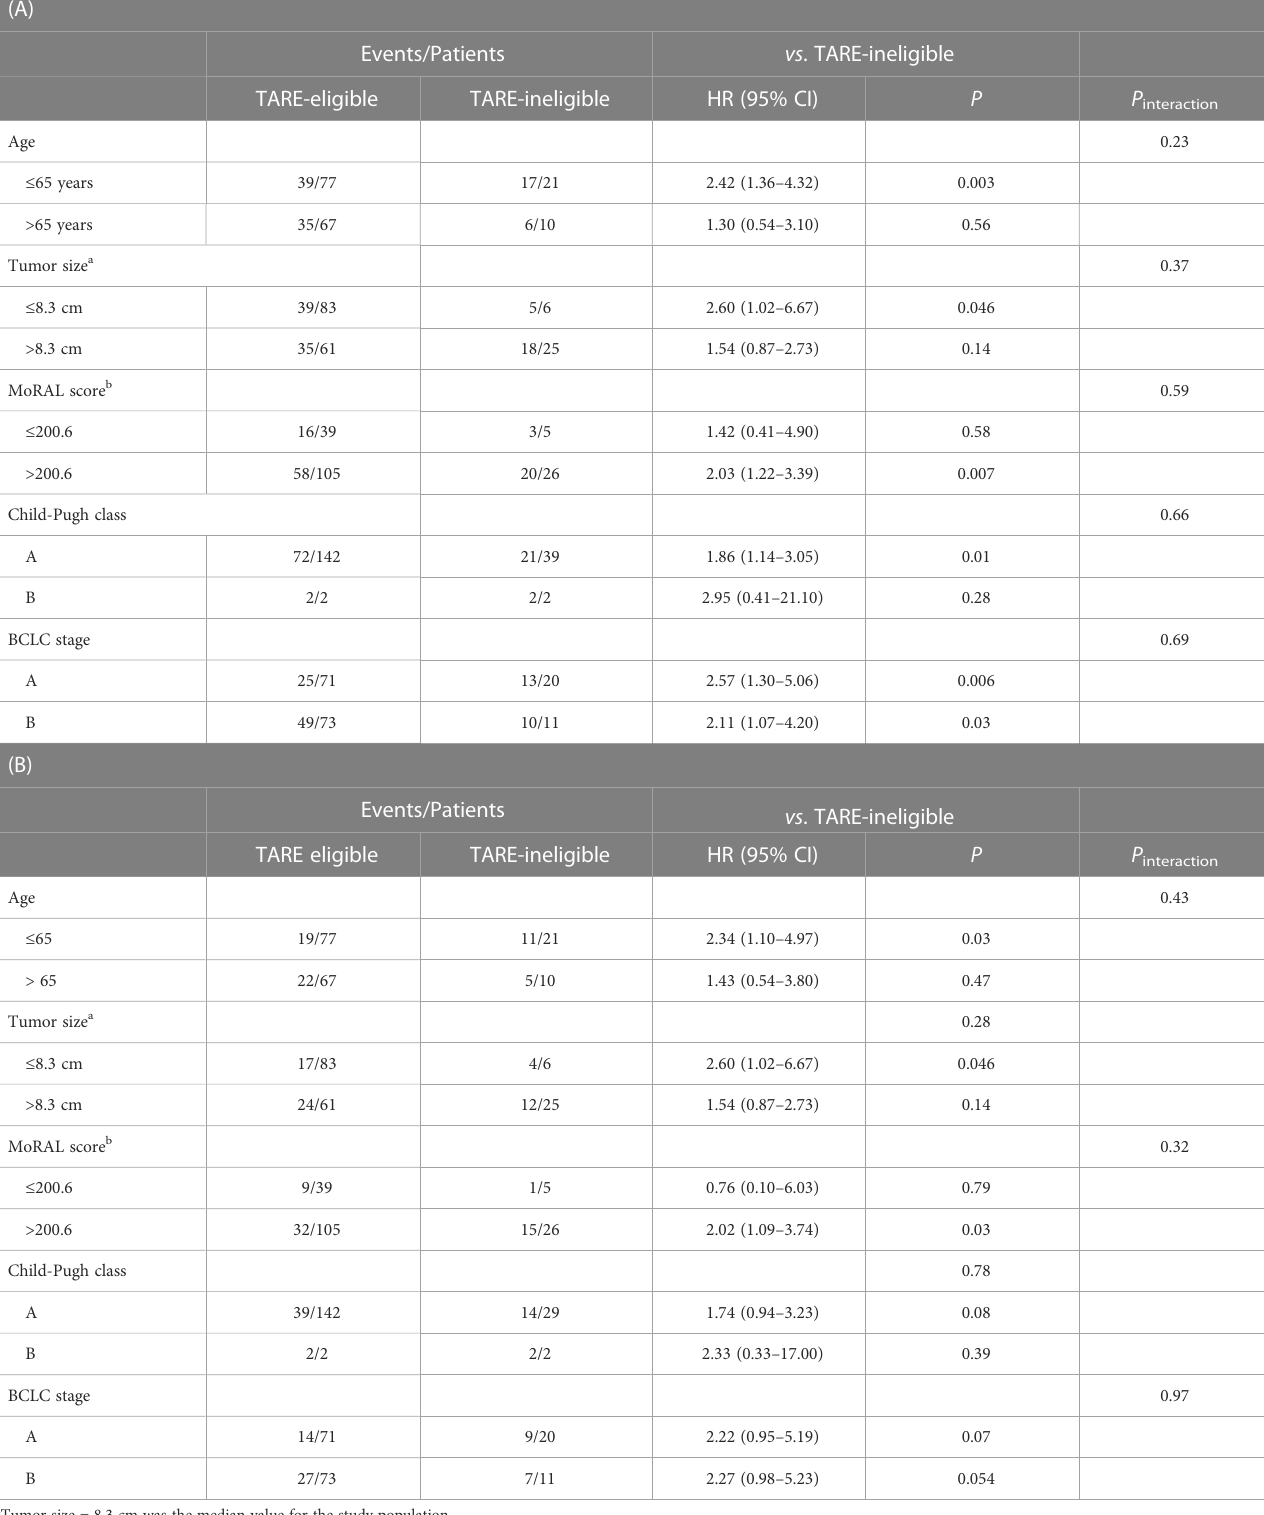
TABLE 5 Subgroup analysis of (A) time-to-progression and (B) overall